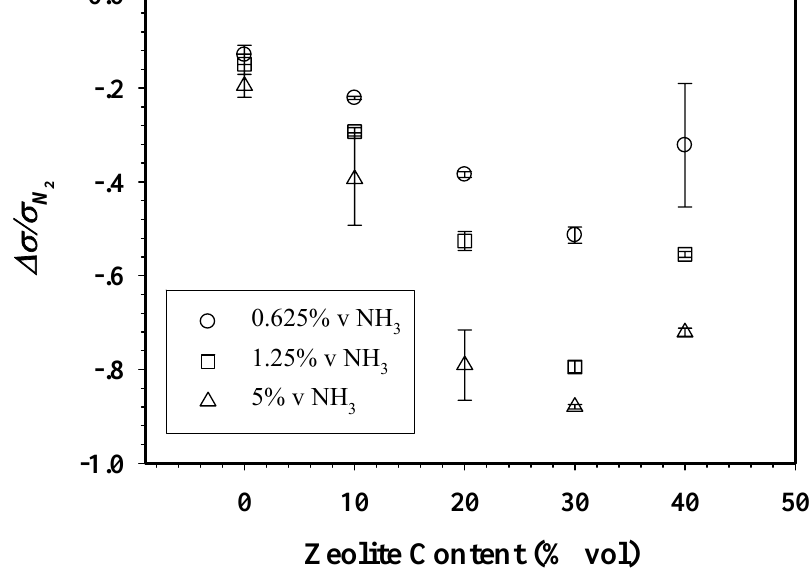
Figure 7. of 50:1dPPP/NaZSM-5(23) composites vs . NaZSM-5(23) content concentrations at 28 ± 1 °C and at 1 when exposed to different NH 3